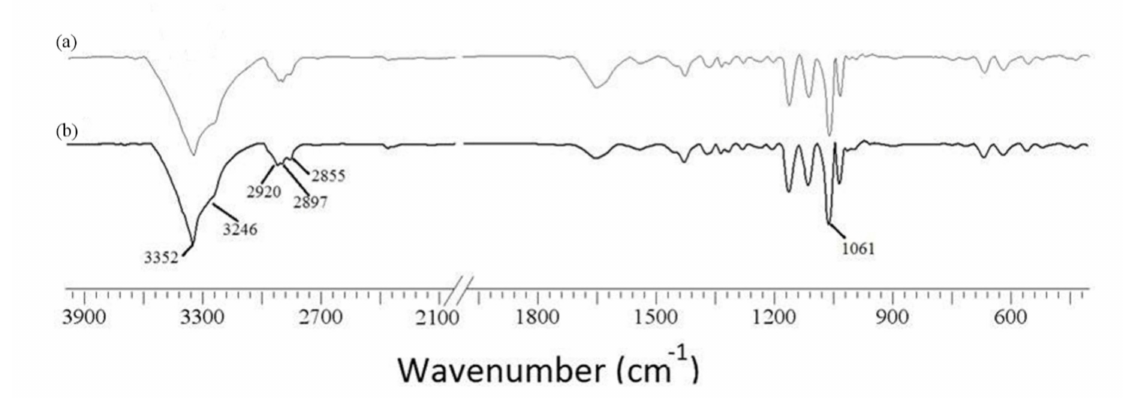
Figure 4. FT-IR spectra of BC produced from ( a ) HS medium and ( b ) molasses. 13 C NMR spectra of BC are shown in Figure 5.